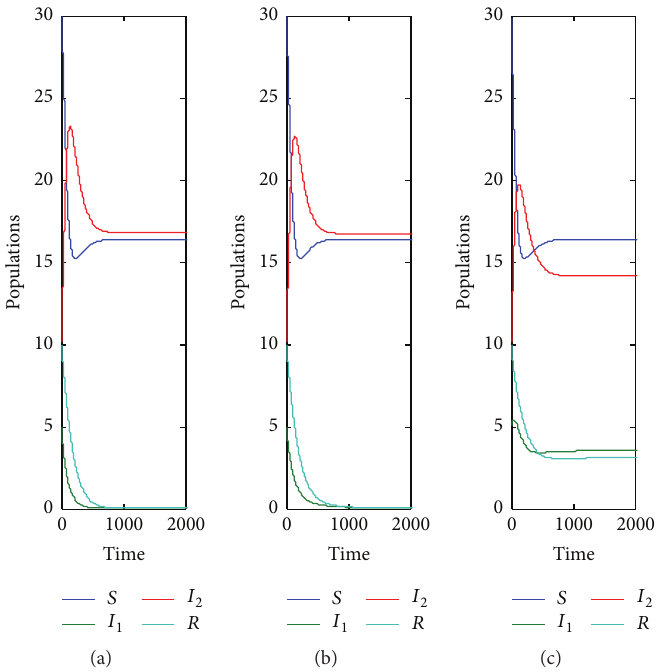
Figure 3: Time series of the solution of model (1) for the data given by (81). (a) For 𝛽 1 = 0.015 the model approaches to 𝐸 1 = (16.4, 0,16.75, 0) . (b) For 𝛽 1 = 0.06 the model approaches to the same point. (c) For 𝛽 1 = 0.3 the model approaches to 𝐸 3 = (16.4, 3.51, 14.1, 3.07) .